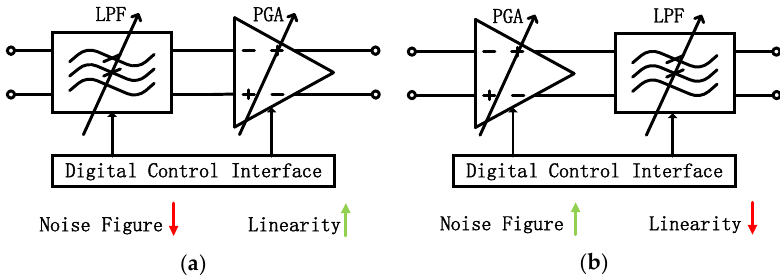
Figure 1. Typicalarchitecturesofanalogbaseband: ( a )low-passfilter(LPF)-firsttopology; ( b )programmable gain amplifier (PGA)-first